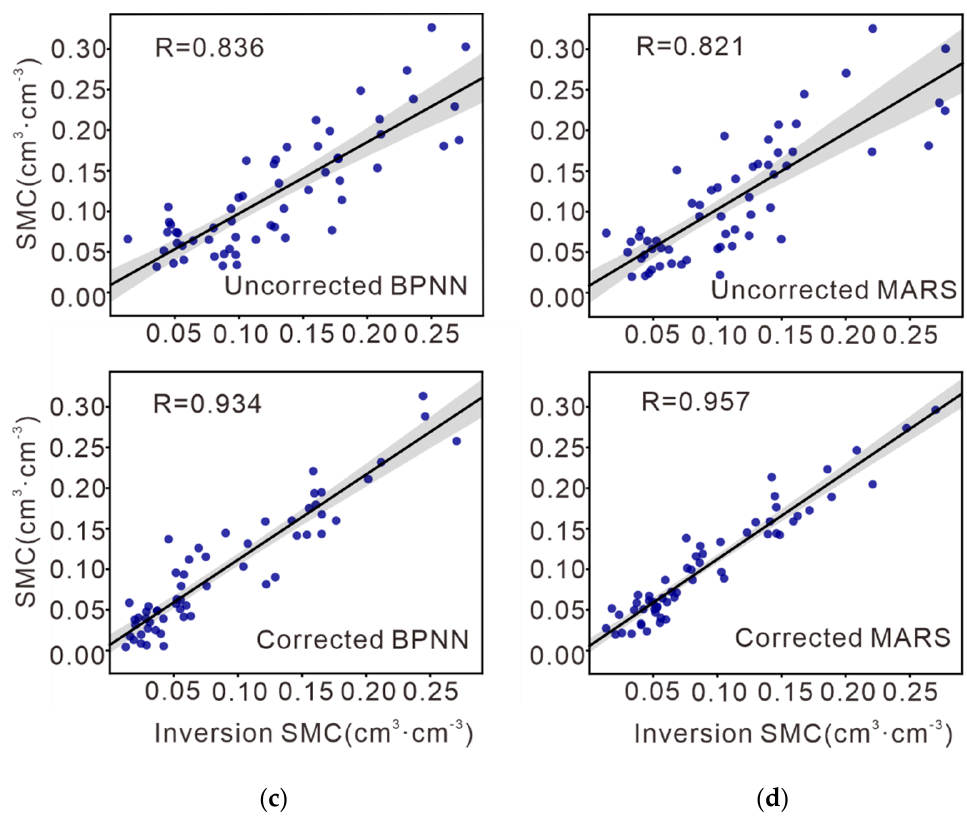
Figure 8. ( a ) Linear regression analysis of the estimation results of MLR with the uncorrected and corrected phases and the reference value of soil moisture. ( b ) Linear regression analysis of the estimation results of SVR with the uncorrected and corrected phase and the reference value of soil moisture. ( c ) Linear regression analysis of the estimation results of MLR with the uncorrected and corrected phases and the reference value of soil moisture. ( d ) Linear regression analysis of the estimation results of MLR with the uncorrected and corrected phases and the reference value of soil moisture.